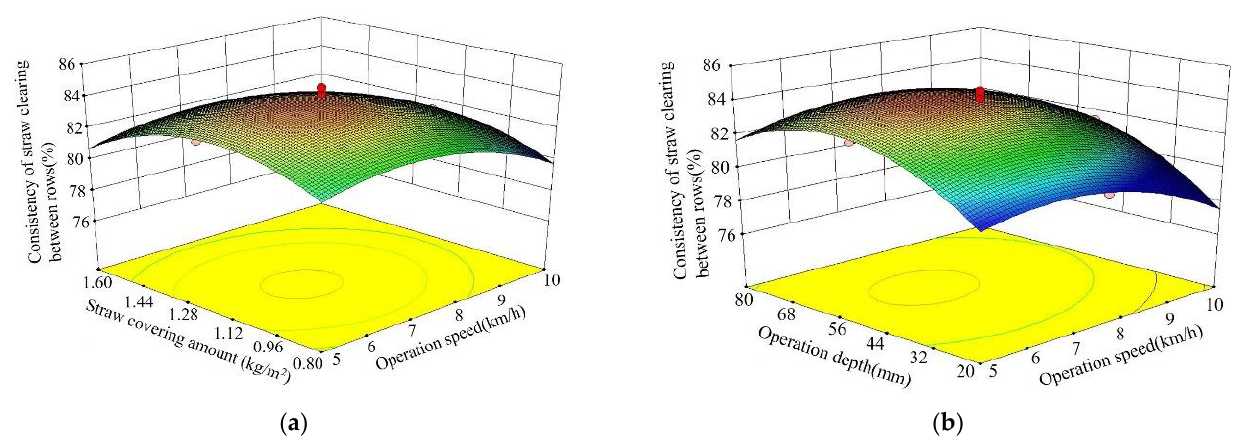
Figure 12. Influence law of various factors on consistency of straw clearing between